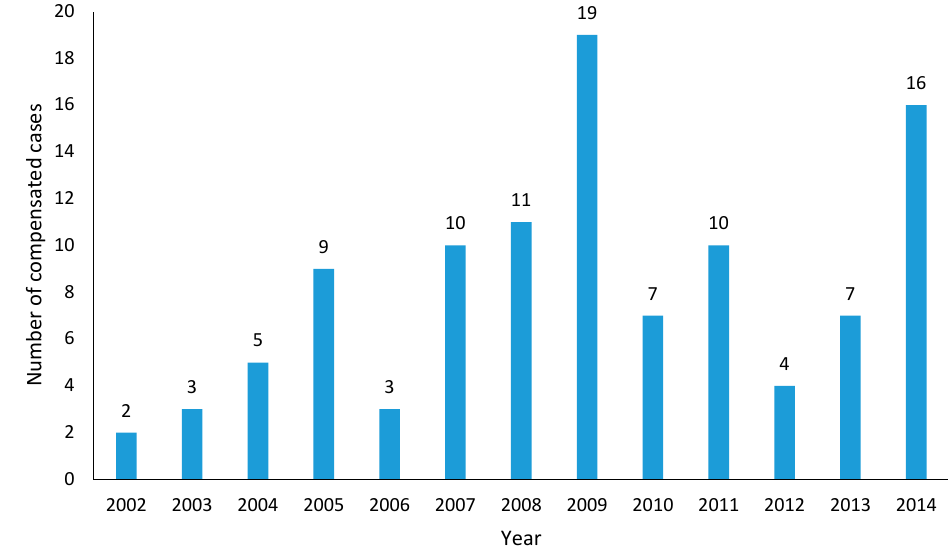
Figure 3. The number of cases compensated for asbestos-related occupational diseases in Korea between 2002 and 2014.